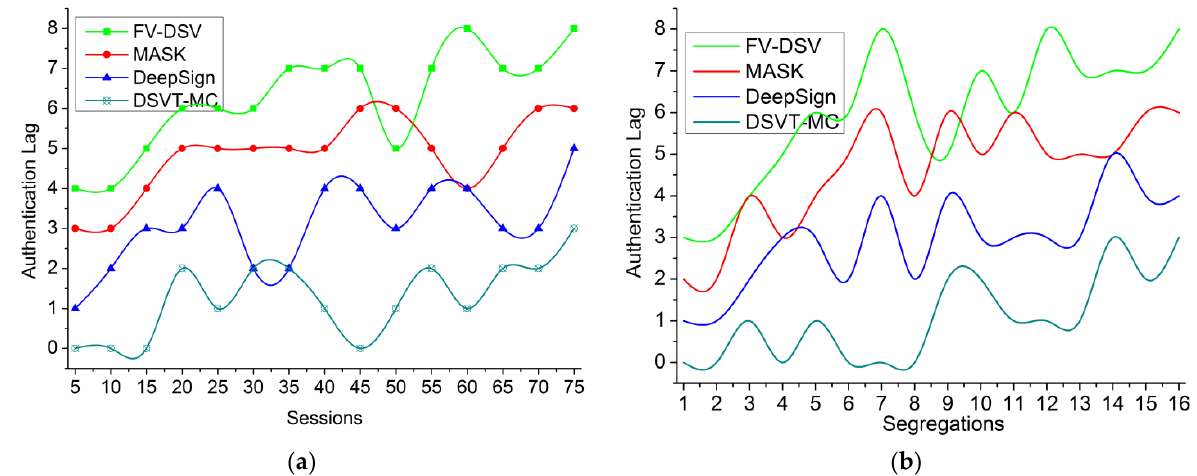
( b ) Figure 13. Complexity Analysis for ( a ) Different Session ( b ) Segregation. 4.3.5. Authentication Lag This proposed technique reduces the authentication lag for concealing individual user information using biometric devices and security systems that are responsible for online and offline signature approval. The accurate information authentication provided in the biometric system using classifier learning is depicted in Figure 14. This technique supports communication and real-time application for securely processing and ex- changing information, and it reduces the verification failure and time by estimating 𝑂𝑁 𝑆 = 𝐴 𝑣𝑒𝑟𝑖𝑓𝑦 + 𝑣𝛼 𝑡 − 𝑉𝐹 and 𝑂𝐹𝐹 𝑆 = 𝑃 𝑣𝑒𝑟𝑖𝑓𝑦 + 𝑣𝛼 𝑡 − 𝑉𝐹 . In this authentication verifi- cation process, the forging activities at the time of digital signing are addressed due to changes in security metrics, and certificates during communication are identified to prevent failures and complexity. This observed human information is concealed be-